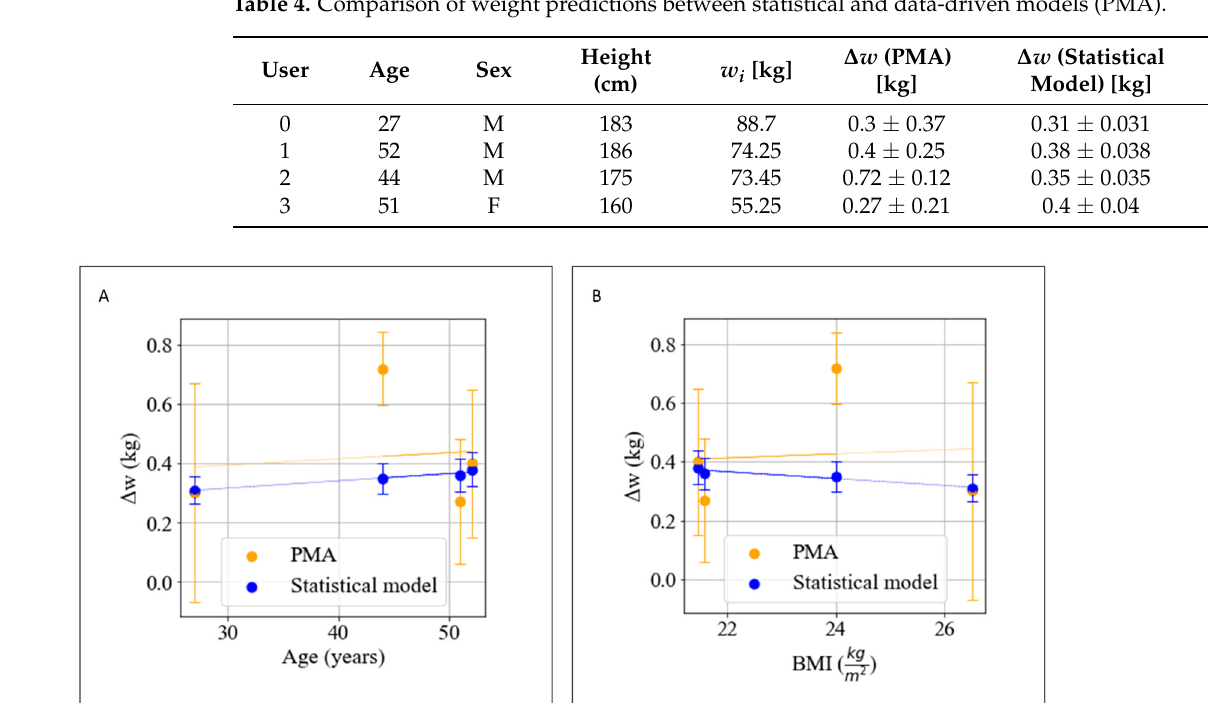
Figure 7. ( A ) Δ𝑤 calculated with PMA and with statistical models with respect to age of users. ( B ) Δ𝑤 calculated with PMA and with statistical models with respect to BMI of users. For the statistical model, an error of 15% was considered, while for PMA, it was considered as an error of the RMSE of the WFS.